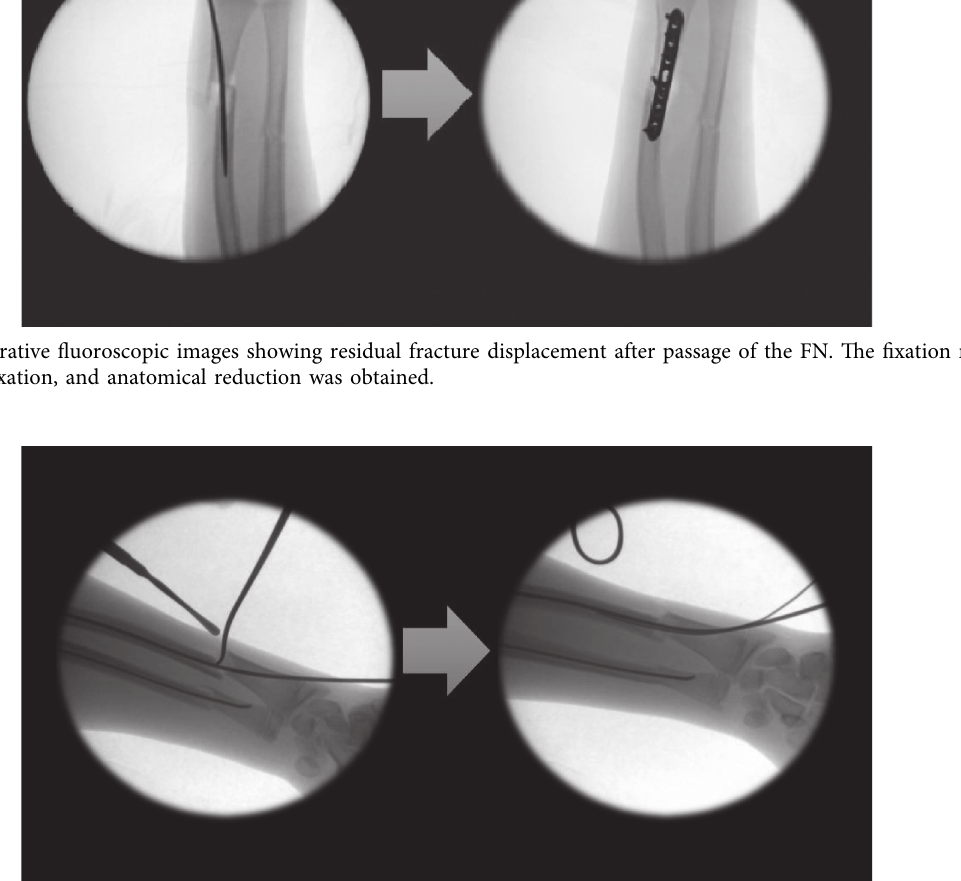
Figure 2: Intraoperative fluoroscopic images showing residual fracture displacement after passage of the FN. Augmentation of fixation was pursued with another